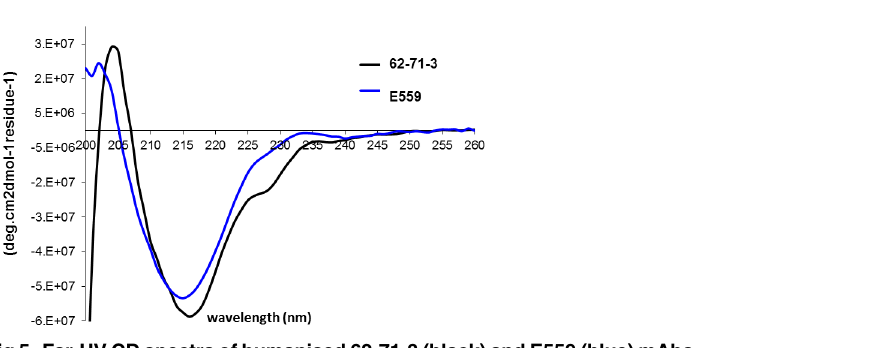
doi:10.1371/journal.pone.0159313.g005